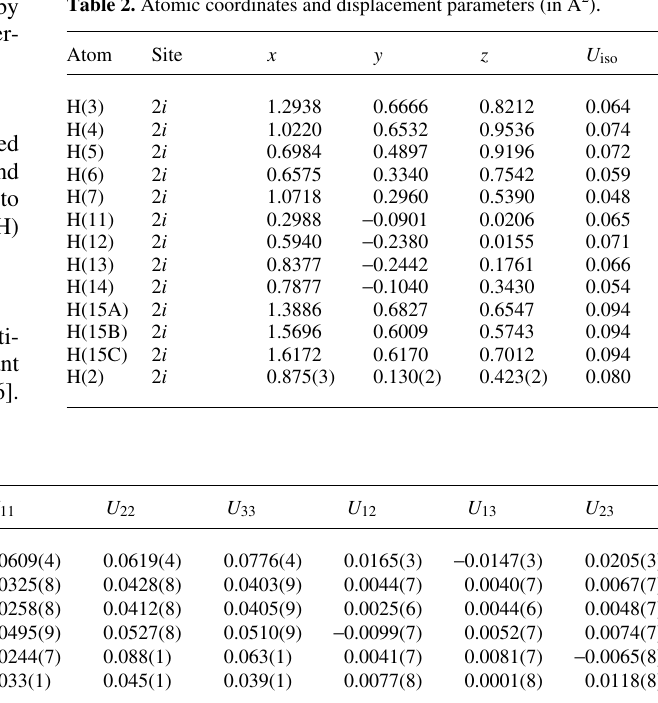
Table 2. Atomic coordinates and displacement parameters (in Å 2 ) .